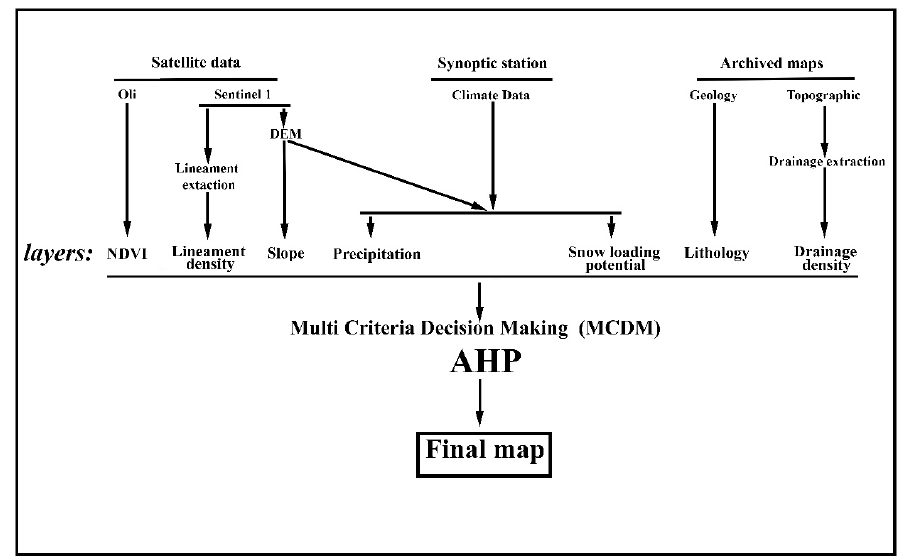
Fig. 3 Flowchart of the procedure of the study, representing the data sources and the path of the data layers